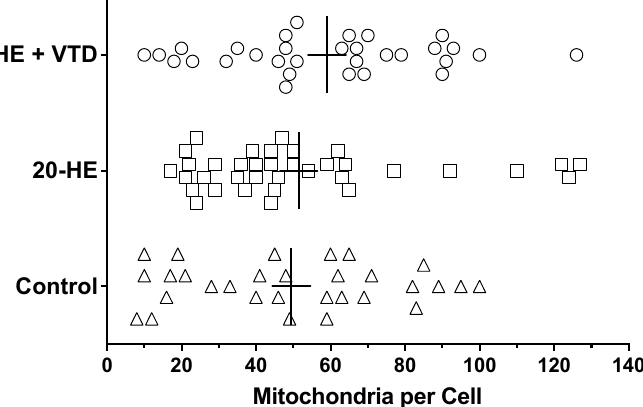
Figure 4. Number of mitochondria per Sf 21 cell. Treatments were 0.1% DMSO (control), 42 µM 20-HE, and 42 µM 20-HE + 1 µM VTD. The vertical line for each group of symbols demarcates the mean with the SEM shown as a horizontal bisecting line. Statistical analysis was performed using one-way ANOVA, but no post-test due to a lack of statistical significance ( p = 0.386). Sample size was at least n = 30 cells/treatment.